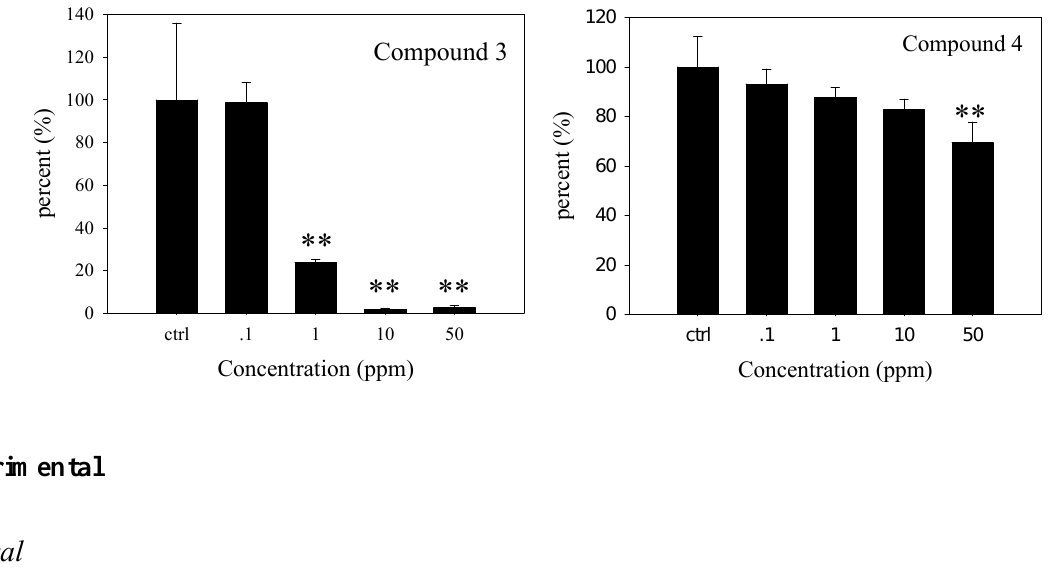
Figure 4. Cont. Compound